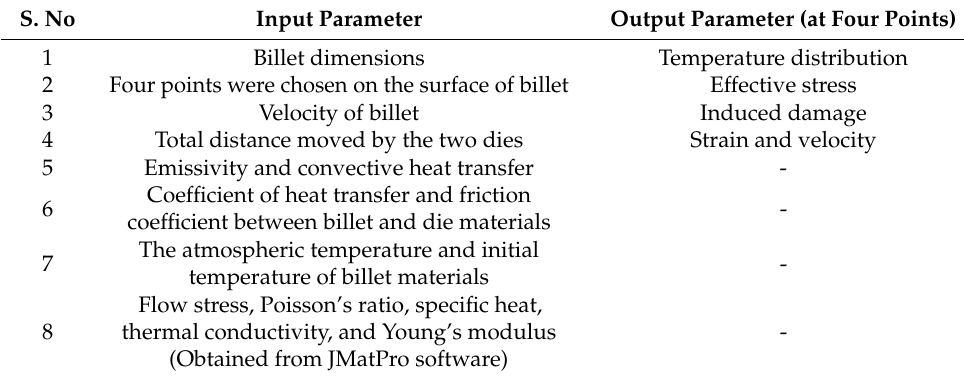
Table 2. Input and output parameters of the forging in DEFORM 3D